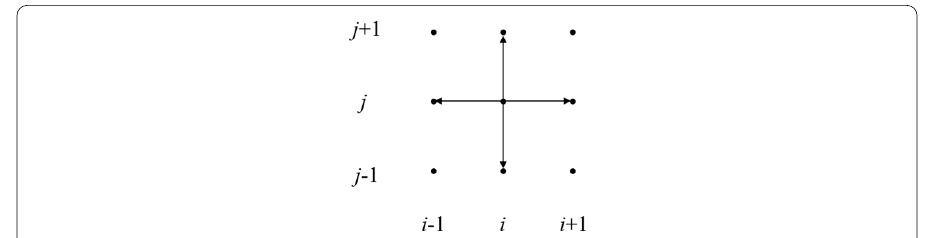
Fig. 8 Schematic diagram of the boundary extraction method. B ( i , j ) is the current pixel, and B ( i , j + 1 ) , B ( i , j − 1 ) , B ( i + 1, j ) , B ( i − 1, j ) represent four adjacent